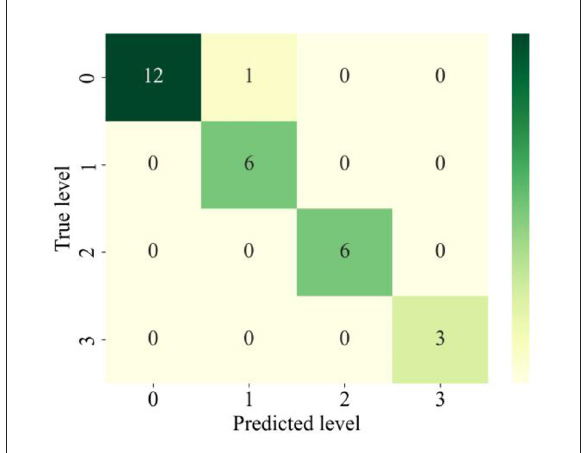
FIGURE9 Confusion matrix of KNN on testing